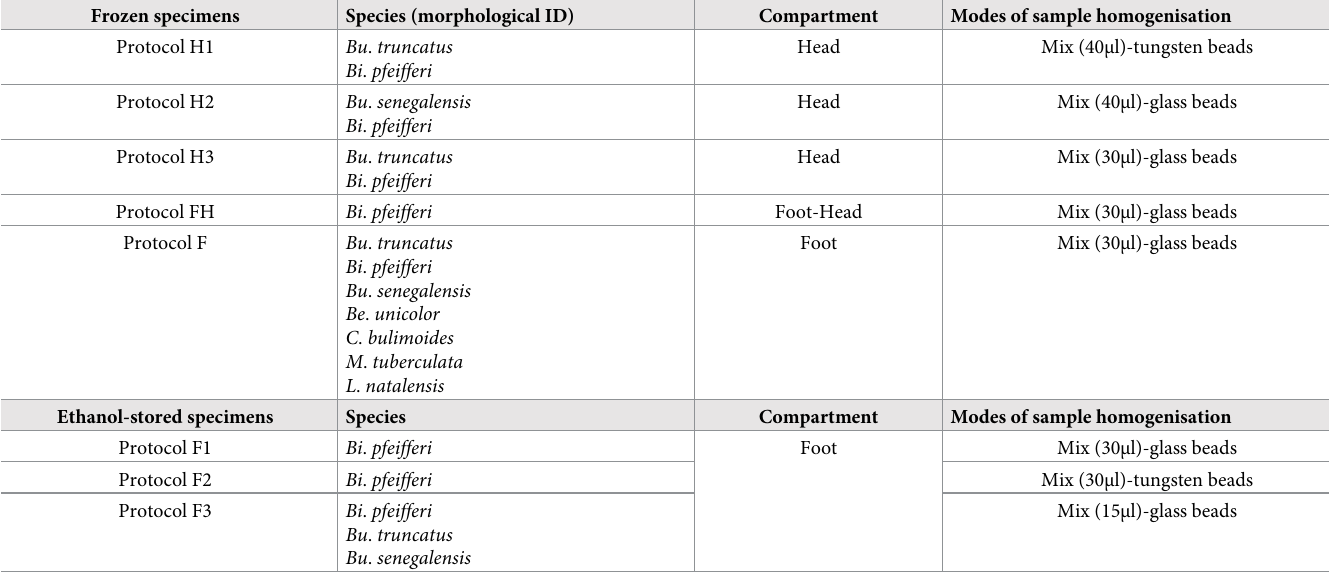
Table 1. The list of protocols and optimized parameters for all sample storage conditions. Frozen